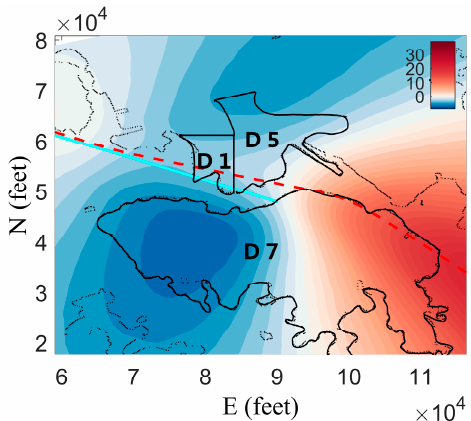
Figure A6. Difference in SEL ( ∆ SEL) between flights BD4 and BD5 (closer view).